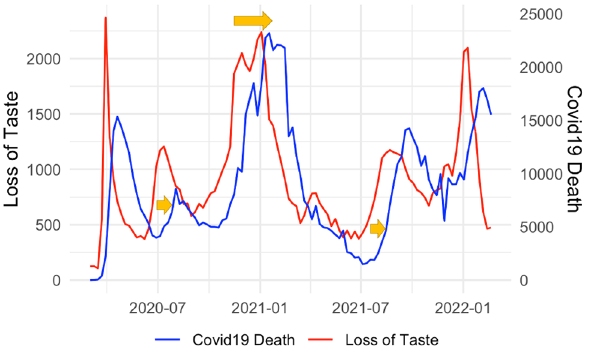
Figure 1. Google search query “loss of taste” and COVID-19 weekly incremental death illustration of delay in peak between Google search query search frequencies (Loss of Taste in red) and COVID-19 national level weekly incremental death (blue). Y-axis are adjusted